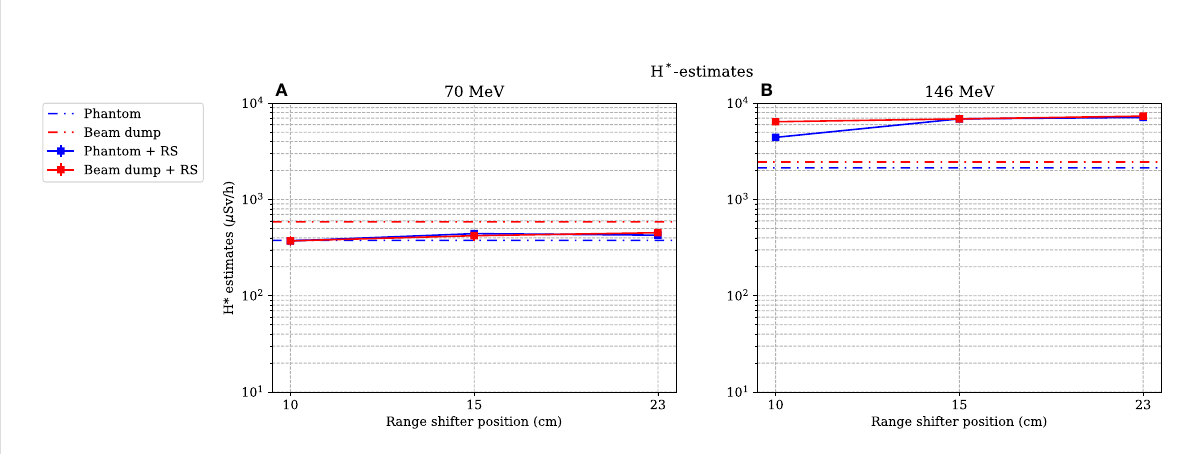
FIGURE 10 Estimation of the dose equivalent at position A, when both the phantom and the proton beam dump are irradiated with 70- and 146-MeV protons (A) and (B) respectively. The lines between data points are used as guide for the eye. The dashed – dotted lines show the levels without a range shifter, i.e., scattered from the phantom or from the beam dump. As mentioned in Section 2.4, the values are illustrated with statistical uncertainties with k =